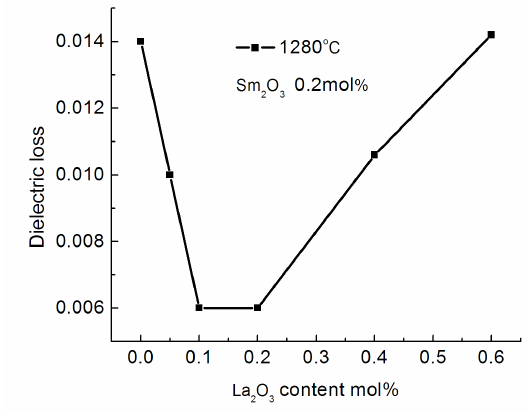
Fig. 4 The relationship curves between the dielectric loss and the content of La O 2 3